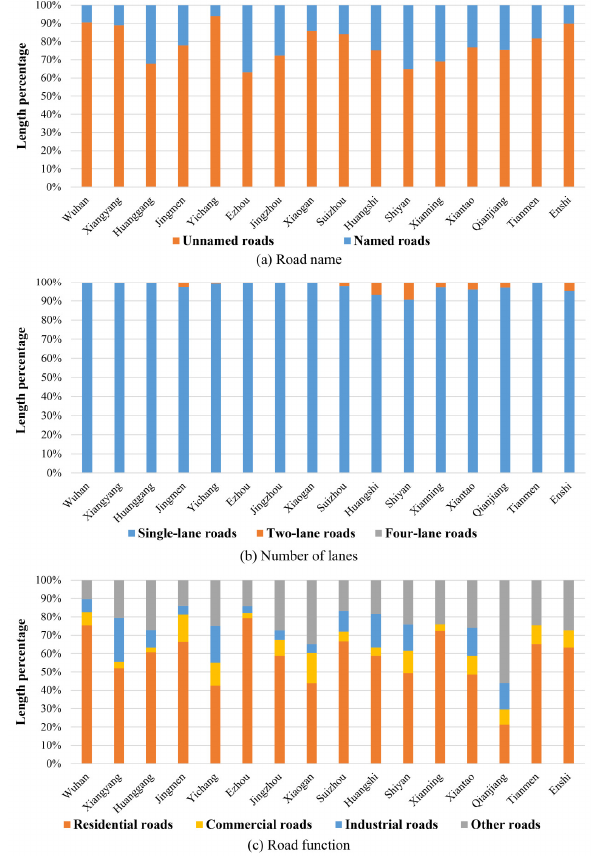
Figure 7. Length percentages of omission roads for the 16 prefecture-level divisions of Hubei (China), in terms of (a) named or unnamed public roads; (b) public roads with different numbers of lanes; and (c) private roads with different functions